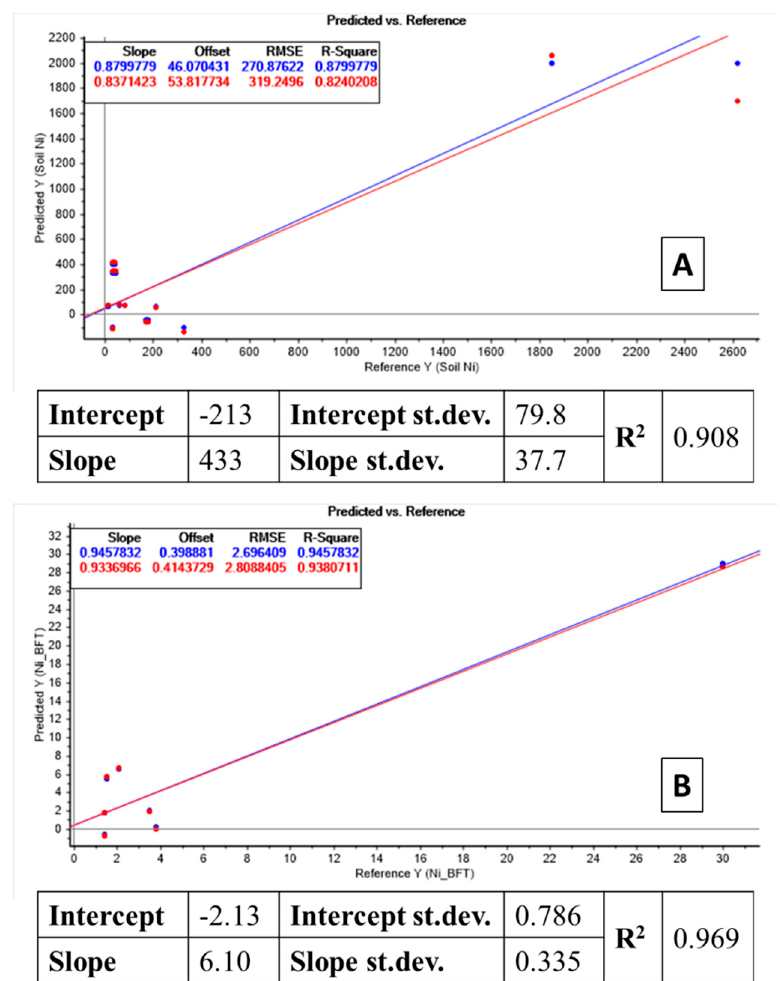
Figure 4. ( A ) Table: Linear regression between total Ni concentration in soil and Ni in S. vulgaris shoots. Plot: recalculated total soil Ni by the model, input data derived from the linear relation between total Ni in soil and Ni in plant. Blue dots: forecasted soil Ni concentrations in calibration mode (all soil data were used as input). Red dots: forecasted soil Ni concentrations in cross-validation mode, excluding one soil data at a time (leave-one-out mode). ( B ) Table: Linear regression between bioavailable Ni concentration in soil and Ni in S. vulgaris shoots. Plot: Recalculated total soil Ni by the model; input data are derived from the linear relation between total Ni in soil and Ni in plant. Blue dots: forecasted soil Ni concentrations in calibration mode (all soil data were used as input). Red dots: forecasted soil Ni concentrations in cross-validation mode, excluding one soil data at a time (leave-one-out mode).